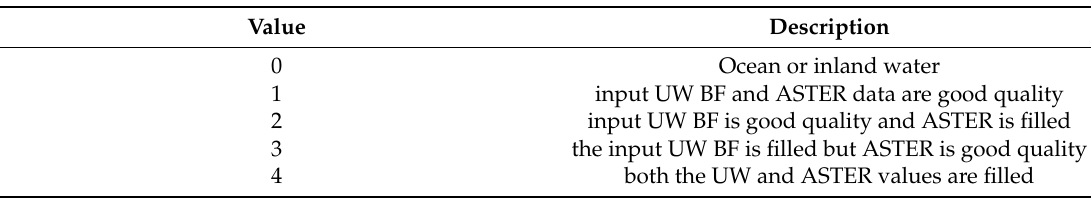
Table 3. Definition of CAMEL quality